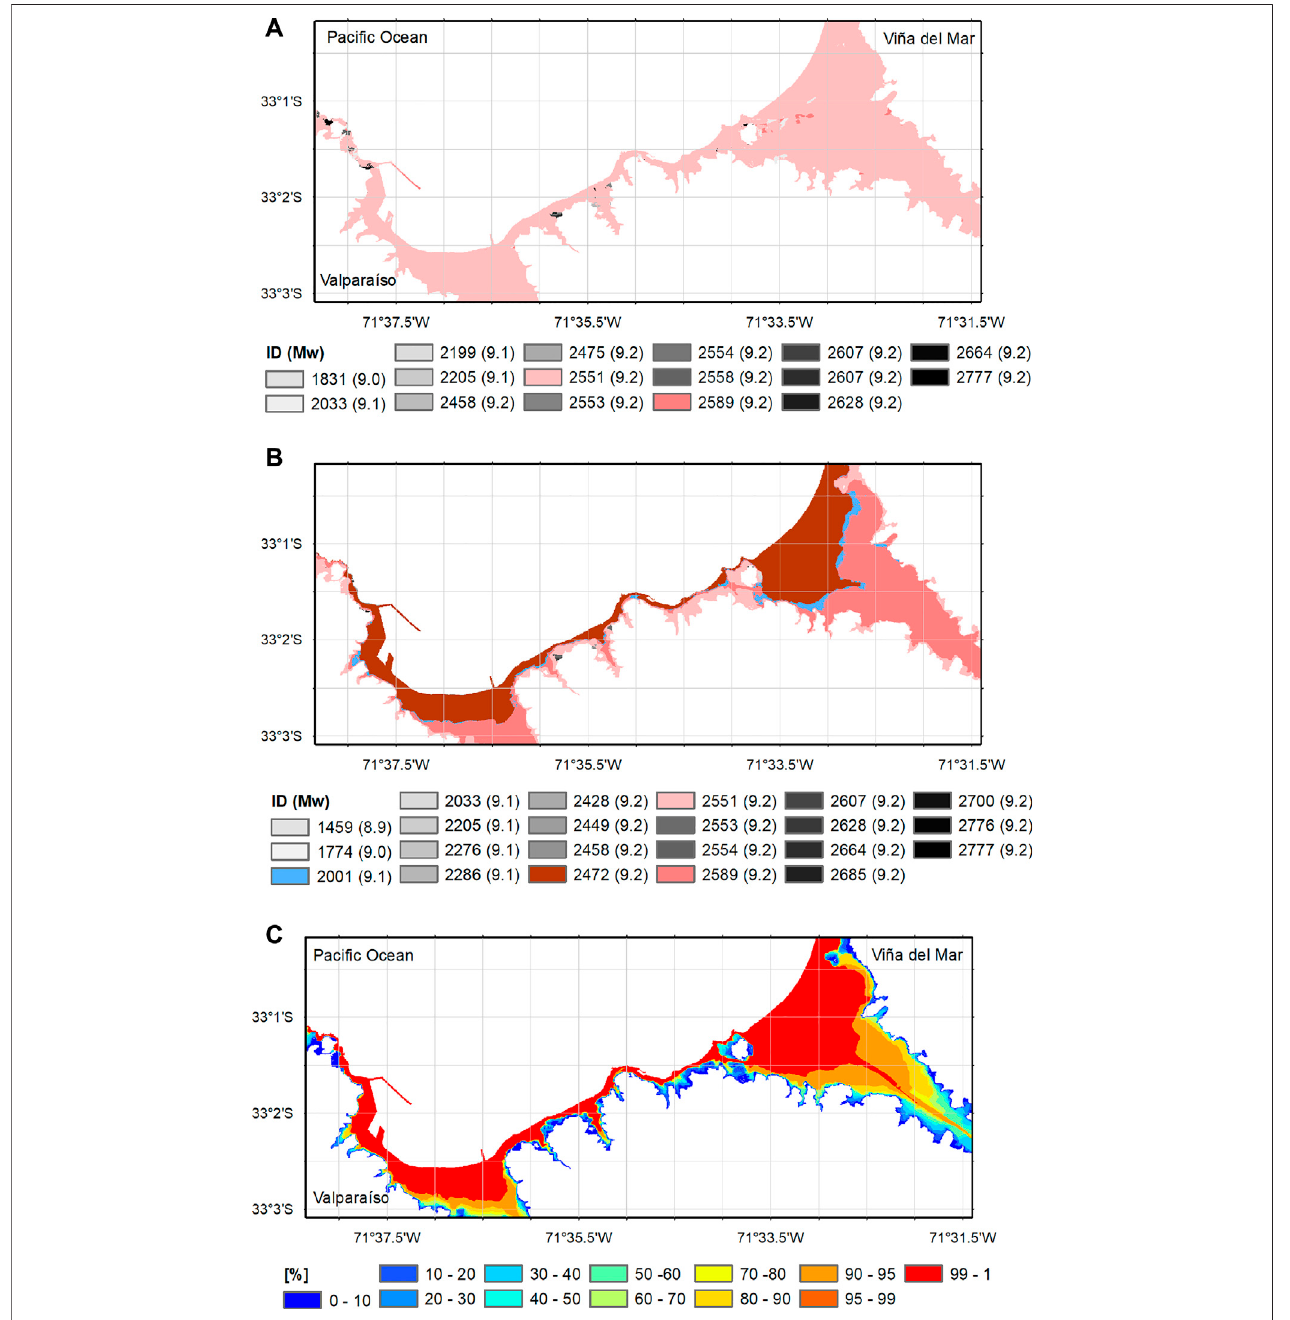
FIGURE9| Discriminationofextreme valuesamongscenarios (A) Scenariosthatcontribute tothemaximum fl owdepth.Leftnumbershowsthescenario Idand in parenthesis the corresponding moment magnitude (B) Scenarios that contributed to the arrival time (C) Fraction of those scenarios that inundate each pixel.